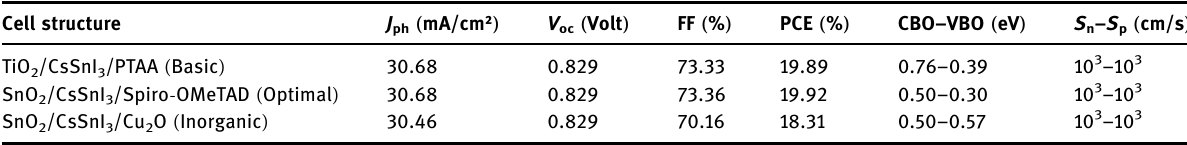
Table 1: Performance of CsSnI 3 - based perovskite cell structures Cell structure